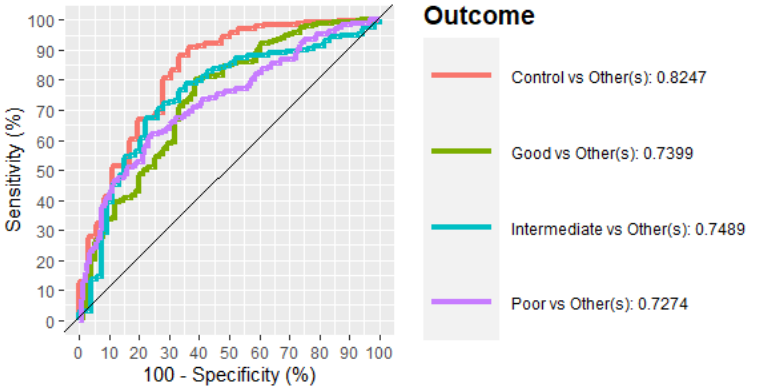
Figure 3. Receiver Operating Characteristic (ROC) curve based on six sPLS-DA components predicting sample performance group or control group designation.